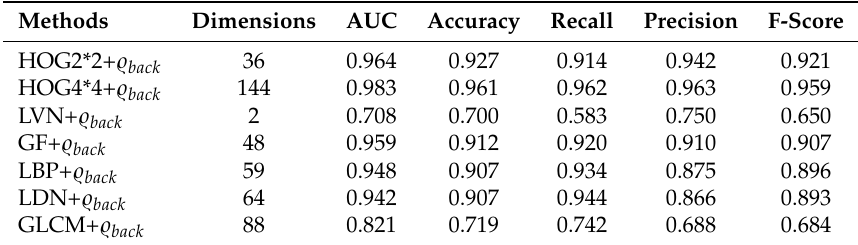
Table 5. The performance of the proposed method when using the representation learned by the backward